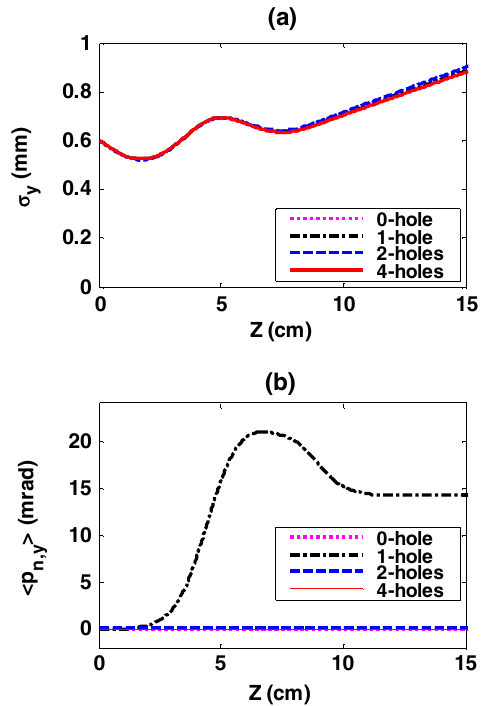
FIG. 6. (a) The rms beam size and (b) normalized transverse momentum of the 0 nC charged beam in the vertical direction without solenoid field drawn by PARGRAF . It is shown that there exists a 14 mrad normalized transverse momentum in the vertical ( y )